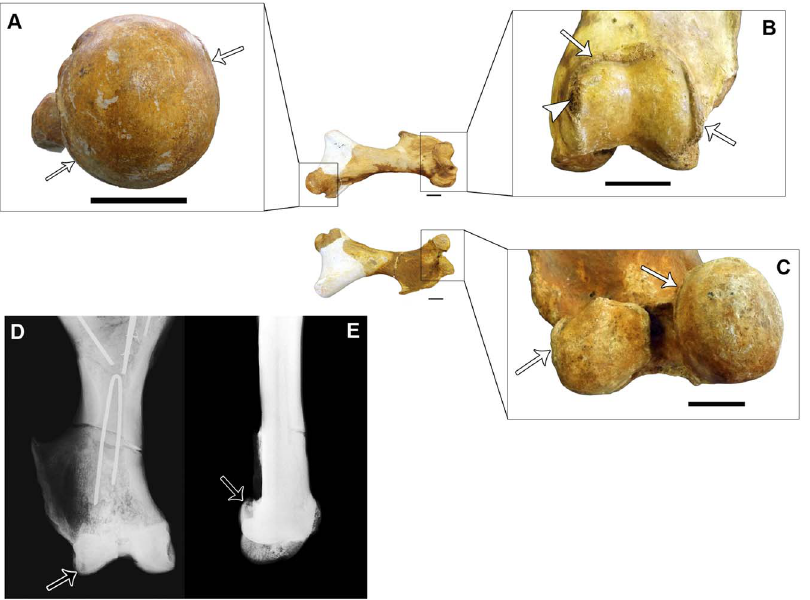
Figure 4. Left femur of Glyptotherium (MCC 1560-V). (A) A detail of the femoral head in proximal view; (B) a detail of the trochlea in cranial view; (C) A detail of the condyles in caudal view; (D) Cranio-caudal radiography of the femur; (E) Lateral radiography. The white arrows indicate osteophytes, the white arrowhead indicates bone erosion and the black arrows indicate subchondral cysts. Scale bars =5 cm.